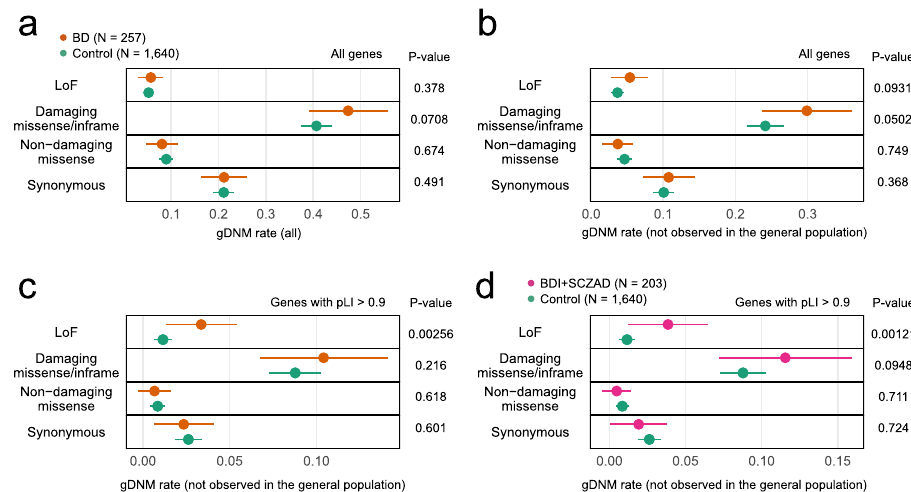
Fig. 1 Patterns of gDNM enrichment in BD. a – d Plots of per-individual rates of the following four types of gDNMs in the affected and unaffected groups: loss of function (LoF), damaging missense/inframe indel, non-damaging missense, and synonymous. Damaging missense gDNMs are de fi ned as those with a Combined Annotation Dependent Depletion (CADD) score >15. a Rates of all gDNMs in BD (orange, N = 257) and controls (green, N = 1640). b Rates of gDNMs not observed in the general population (gnomAD and ToMMo) in BD and controls. c Rates of gDNMs not observed in the general population and hitting a constrained gene (pLI > 0.9) in BD and controls. d Rates of gDNMs not observed in the general population and hitting a constrained gene (pLI > 0.9) in bipolar I or schizoaffective disorder (BDI + SCZAD, magenta, N = 203) and controls. The mean of gDNM counts in the affected and unaffected groups for each mutational type is indicated as the colored points accompanied by the error bars (95% con fi dence intervals). Uncorrected P values calculated by one-tailed permutation tests are shown on the right of the